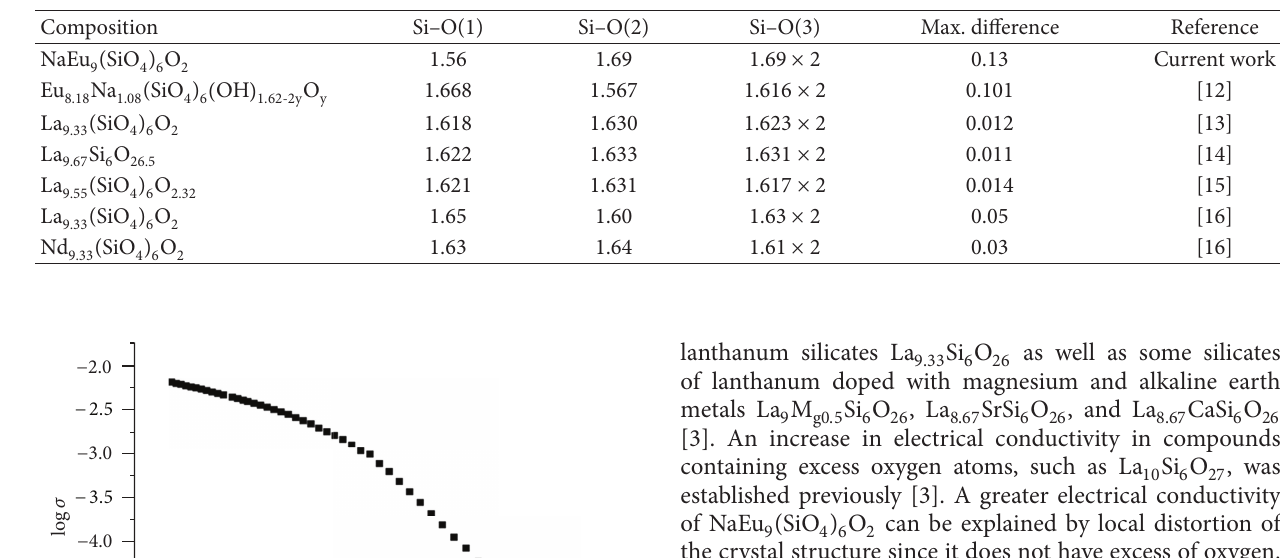
T 5: Selected interatomic distances,